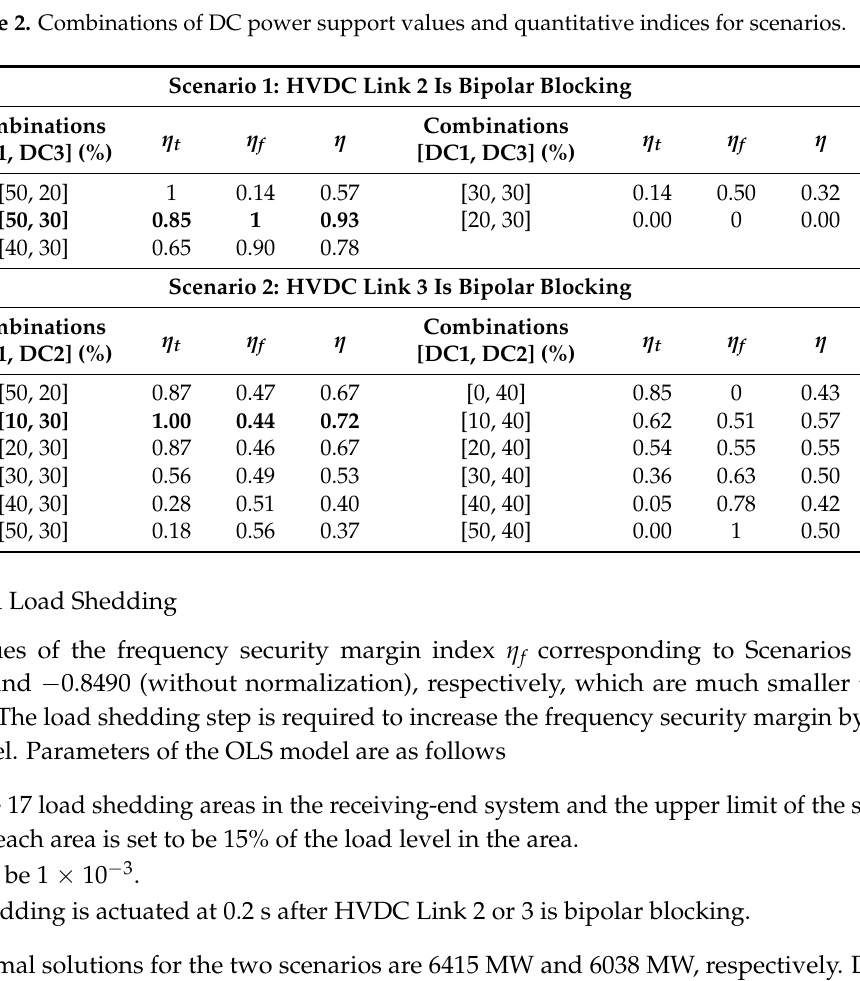
Table 2. Combinations of DC power support values and quantitative indices for